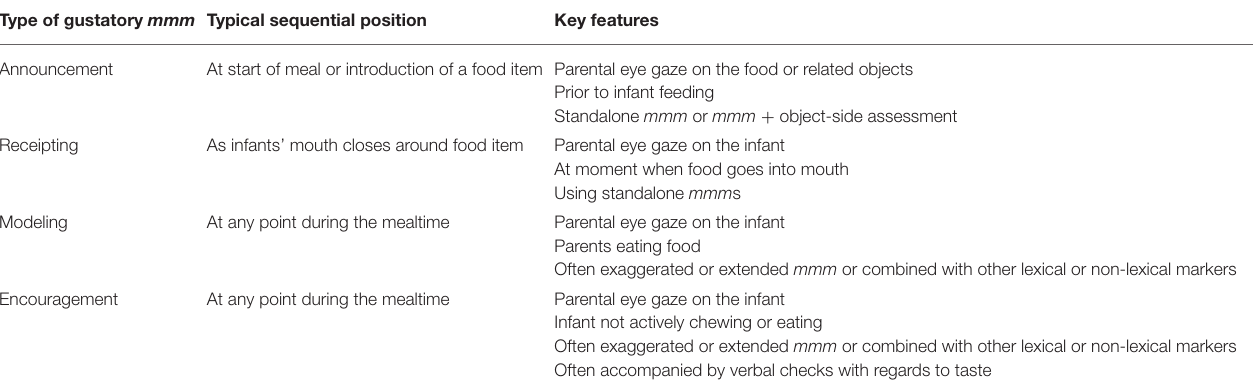
TABLE 3 | Summary of types of gustatory mmm during infant mealtimes. Type of gustatory mmm Typical sequential position Key